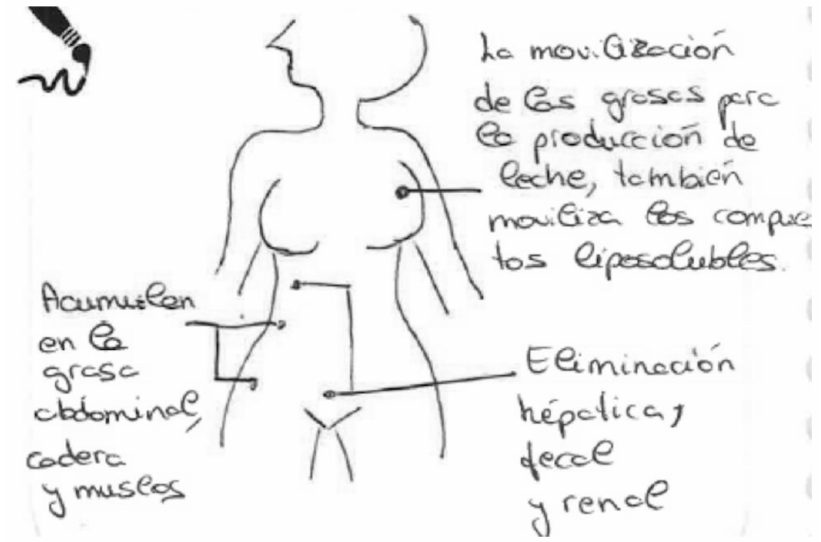
Figure 12. Breastfeeding, university education, secondary school teacher.